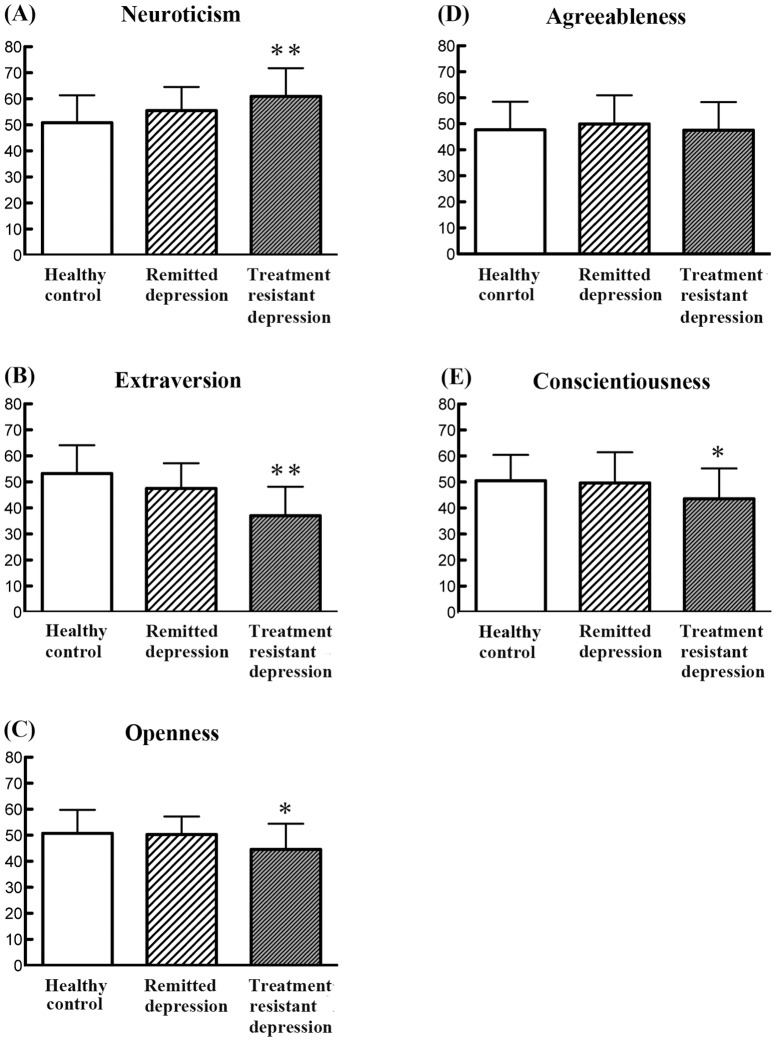
Analysis of variance shows a significant difference between three groups for (A) Neuroticism (F (2,125) = 11.10; P<0.001), (B) Extraversion (F (2,125) = 26.42; P<0.001), (C) Openness (F (2,125) = 5.93; P = 0.004), and (E) Conscientiousness (F (2,125) = 4.88; P = 0.009).In (D) Agreeableness, there is not a significant difference between three groups (F (2,125) = 0.49; P = 0.616). *P<0.01, **P<0.001 compared to control (ANOVA followed by Scheffe test).